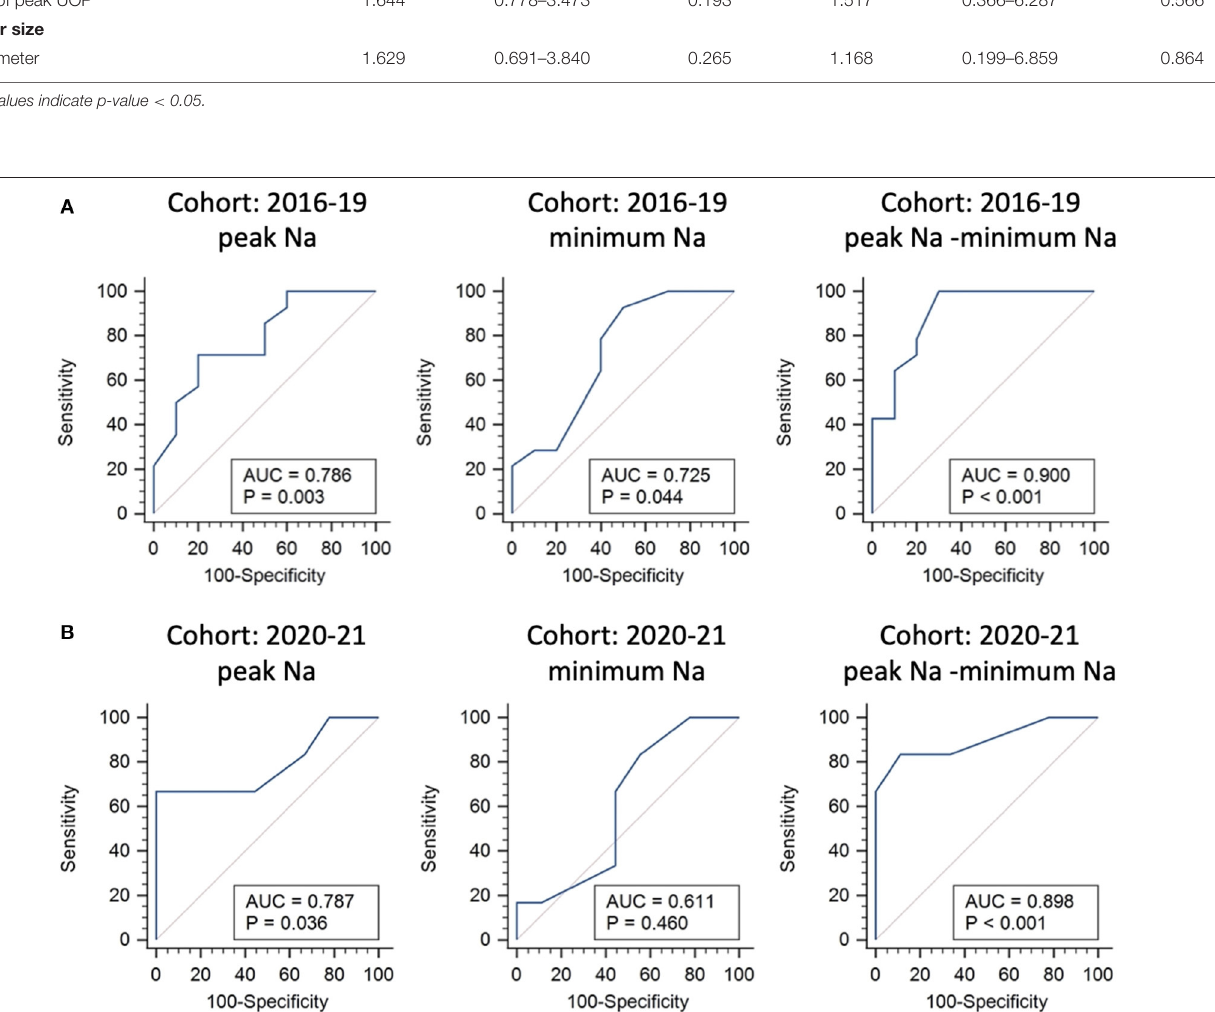
Frontiers in Neurology |